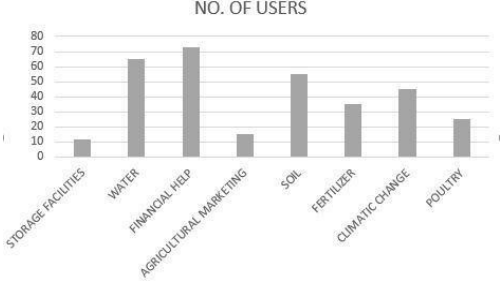
Figure 7. Graphical representation of analysis using cosine sim- ilarity